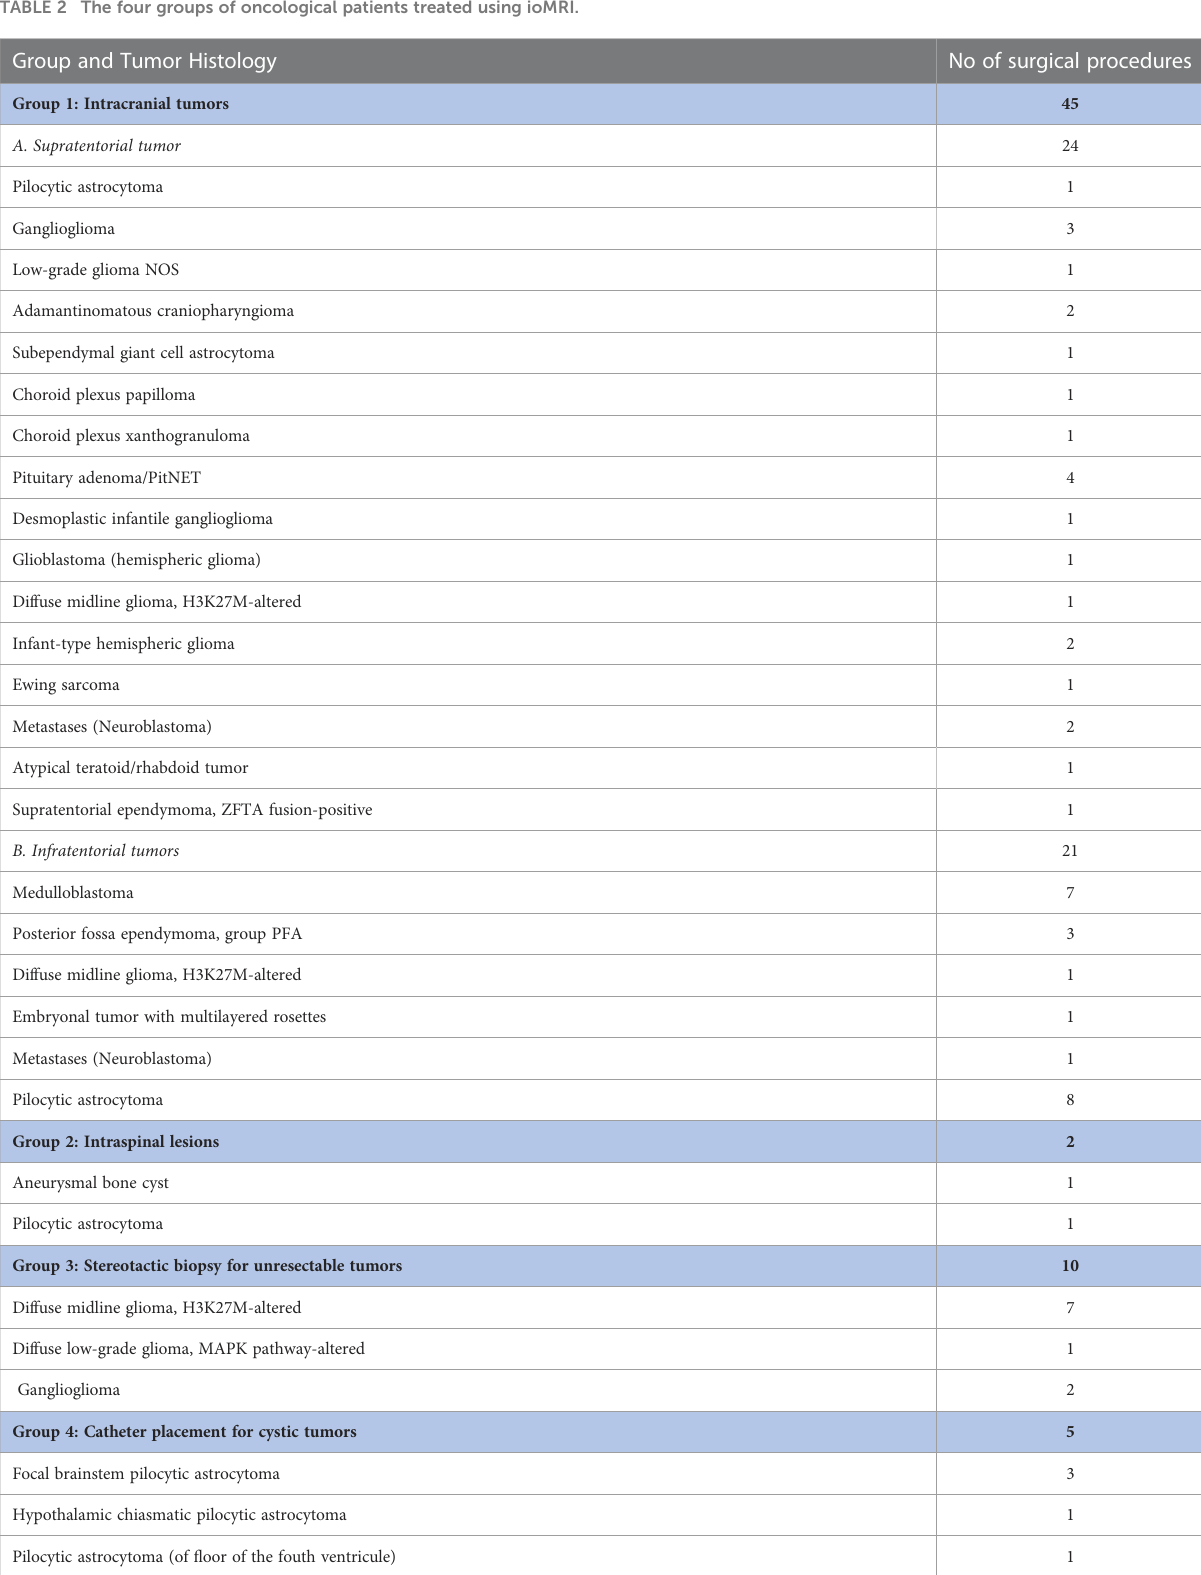
TABLE 2 The four groups of oncological patients treated using